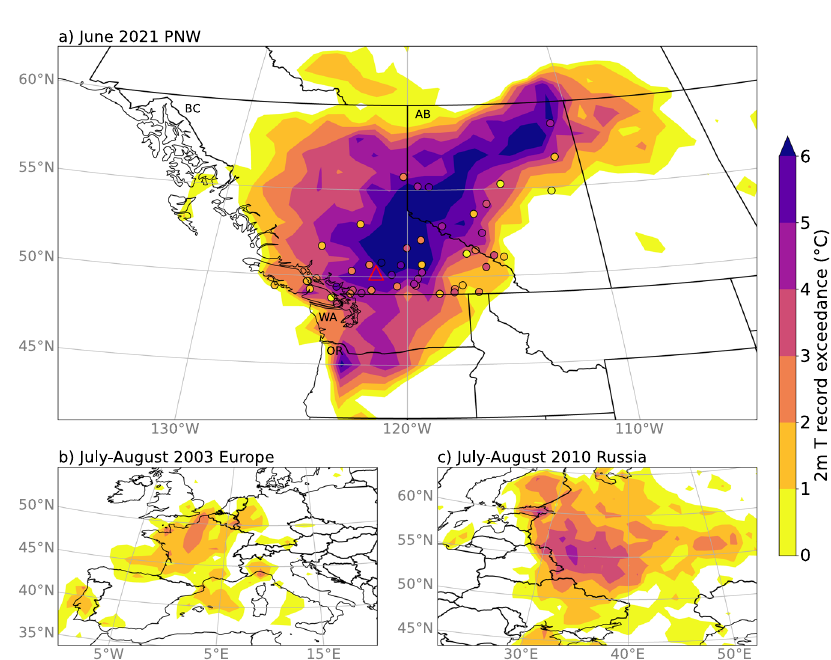
Fig. 2 | Temperature record exceedances. Exceedance of previous record high temperaturesduring a theJune2021Paci fi cNorthwestheatwave, b theJuly – August Europeanheatwaveof2003,and c theJuly – AugustRussianheatwaveof2010.Filled